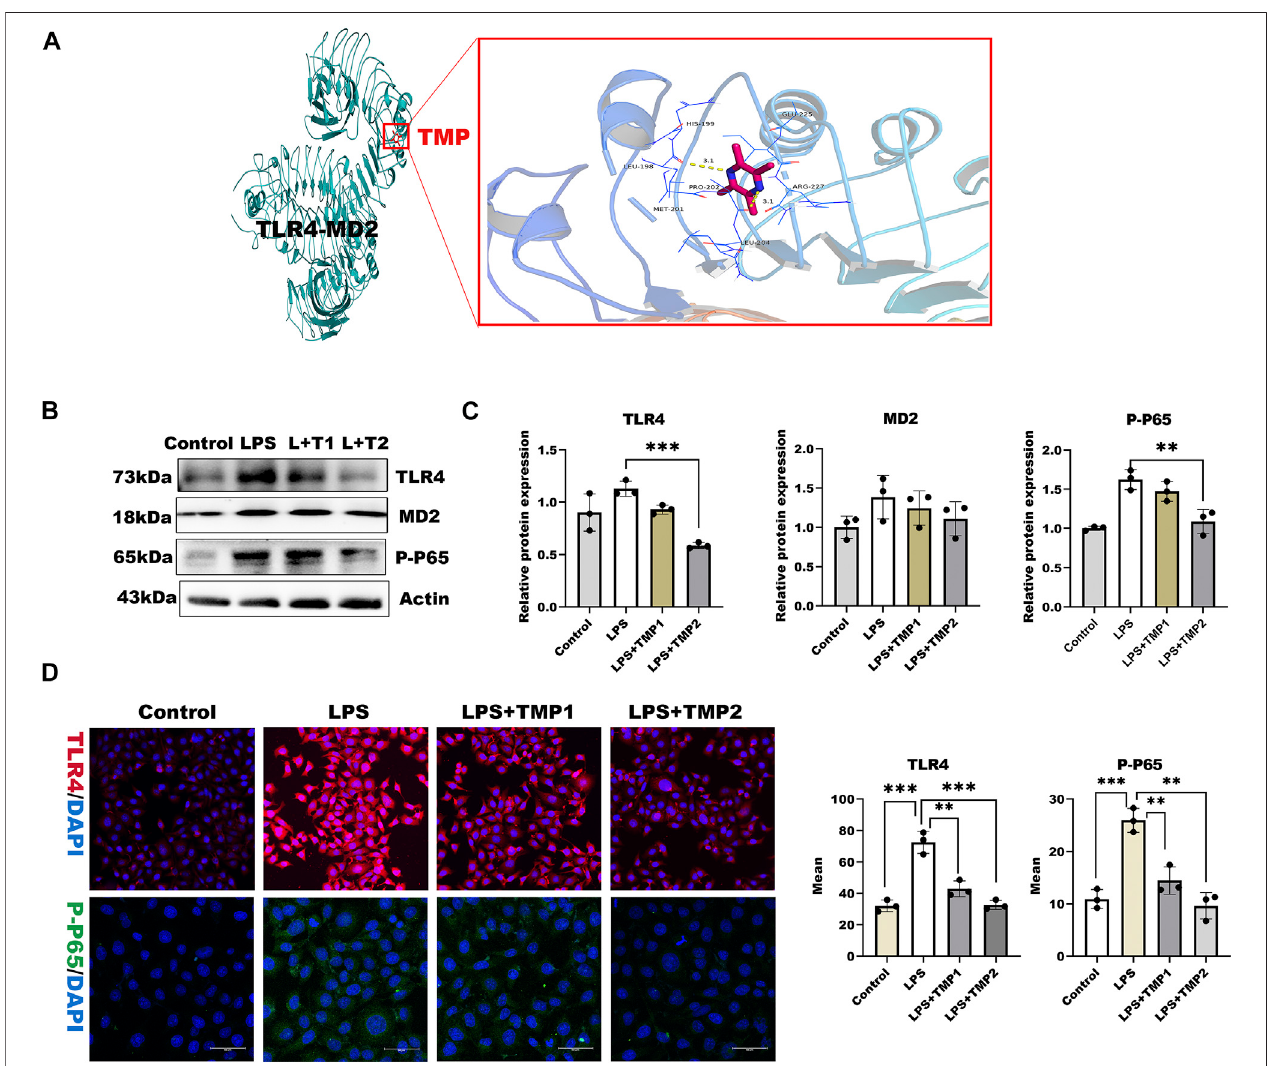
FIGURE4| TMPexertsprotectiononglycocalyxthroughTLR4/NF- κ Bpathway (A) TMPwasdockedwithTLR4-MD2complexesbymoleculardockingtechnique (B) Western blot analysis of Proteins on the signaling axis in HUVEC treated with LPS and TMP (C) Quantitative analysis of protein bands were performed by ImageJ software (D) HUVEC were detected by fl uorescence microscopy analysis using TLR4 (Red), phosphorylated NF- κ B (Green) and DAPI (Blue) and Mean fl uorescence quantitative statistic ( n (cid:2) 3). Bar: 100 μ m * p < 0.05. ** p < 0.005; *** p < 0.001.